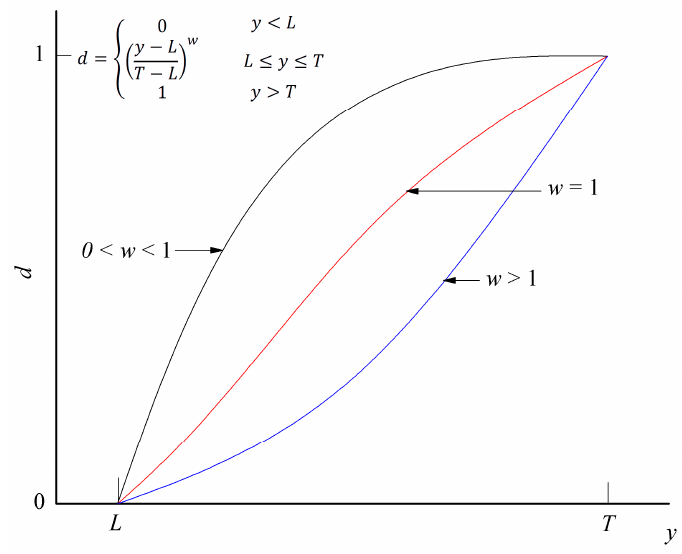
Figure 4. Desirability function targeted to maximize y.